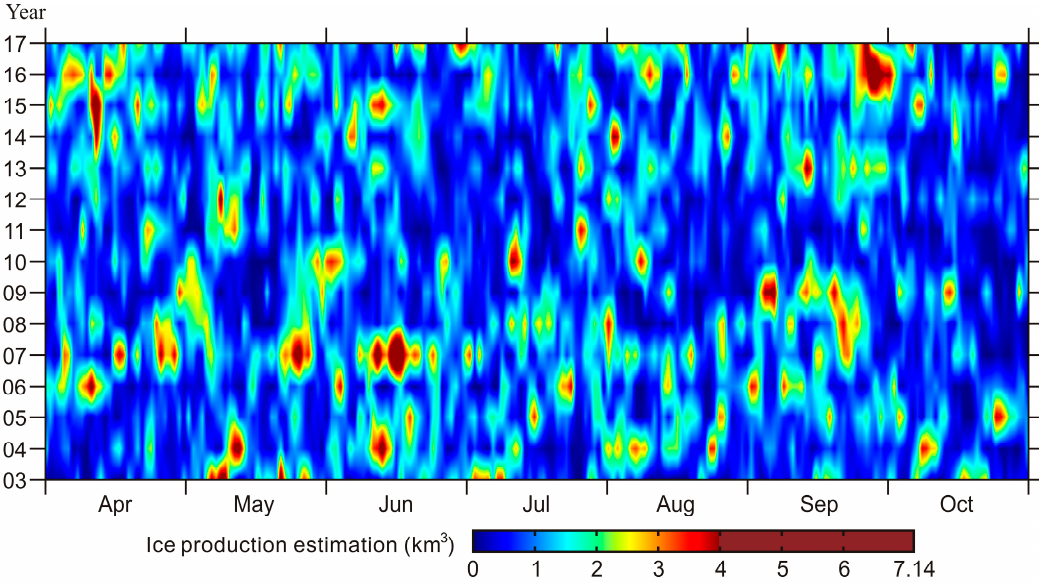
Figure 4. Hovmöller diagram of daily RISP sea ice production between 2003 and 2017, from April to October. The X -axis indicates the month and date; the Y -axis indicates the year.